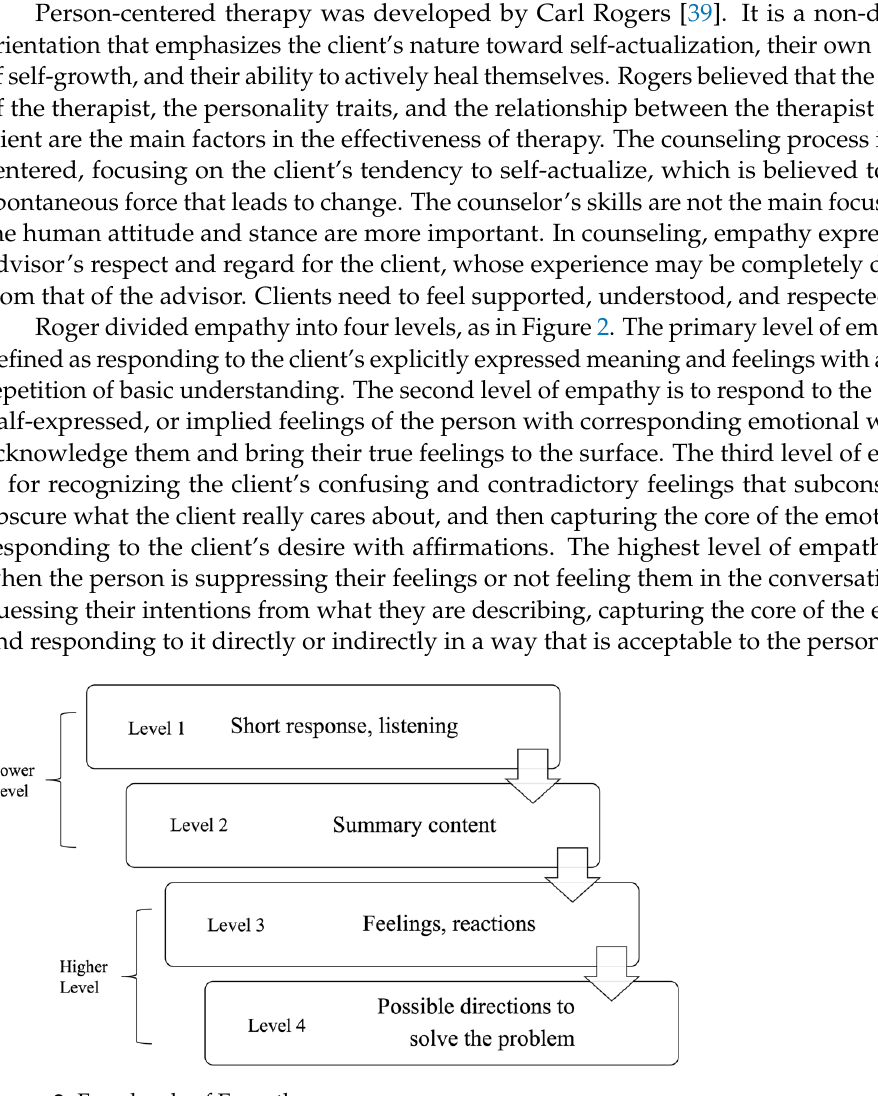
Figure 2. Four levels of